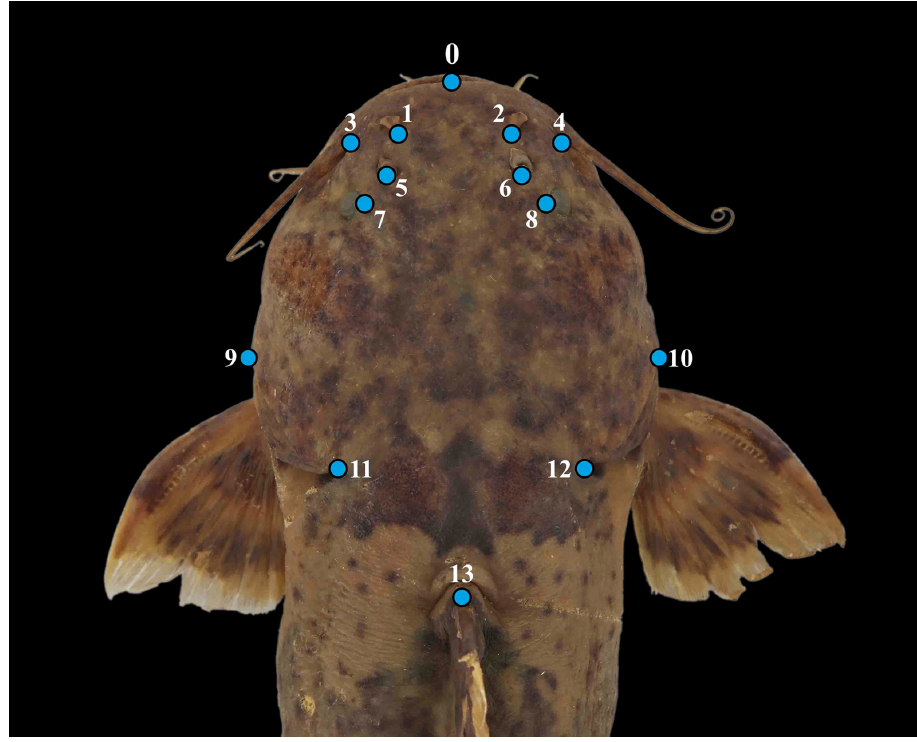
FIGURE 3 | Landmark position on Pseudopimelodus mangurus , MZUEL 1073, 185.2 mm SL. 0 = Tip of snout; 1 = Posterior margin of the left anterior nostril; 2= Posterior margin of the right anterior nostril; 3 = Insertion of left maxillary barbel; 4 = Insertion of right maxillary barbel; 5 = Posterior margin of the left posterior nostril; 6 = Posterior margin of the right posterior nostril; 7 = Medial margin of left eye; 8 = Medial margin of right eye; 9 = Most lateral point of the head in the left; 10 = Most lateral point of the head in the right; 11 = Upper end of the left operculum; 12 = Upper end of the right operculum; 13 = Insertion of dorsal fin